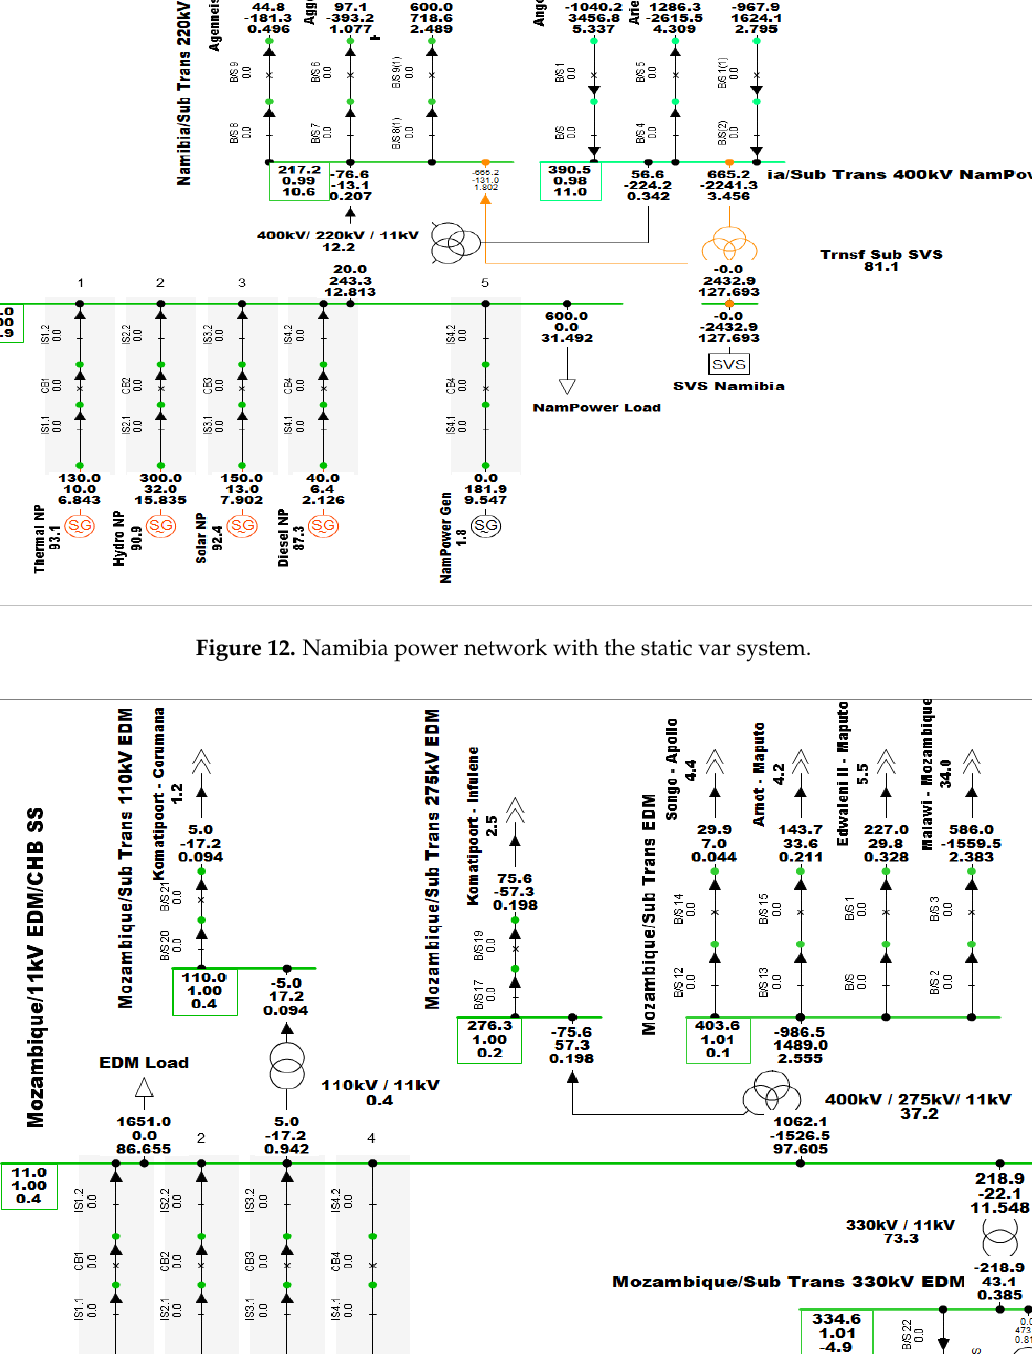
Figure 11. Voltage instability in the Mozambique electric network.